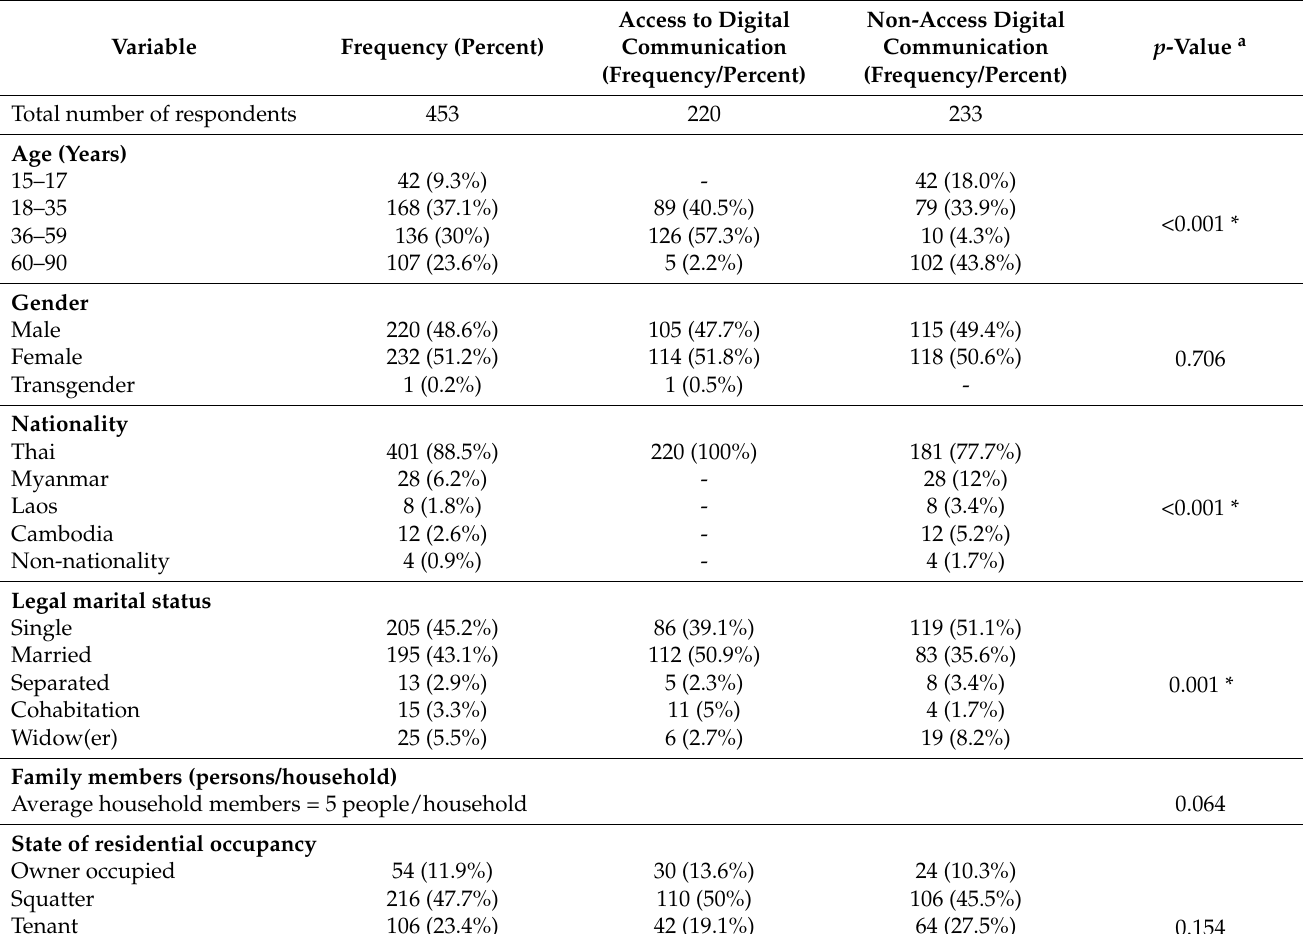
Table 1. Sample demographics and comparisons among respondents. Comparison between the digital information access and non-access groups ( n =